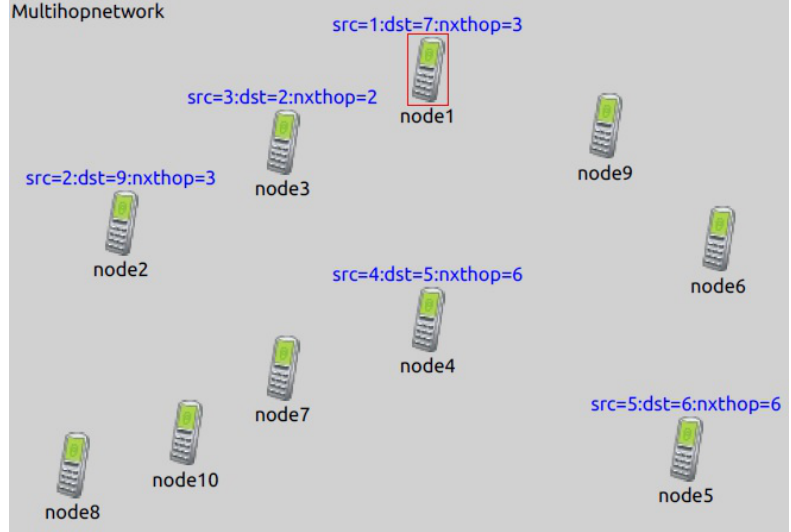
Figure 8. Network topology of ten nodes with M = 5.